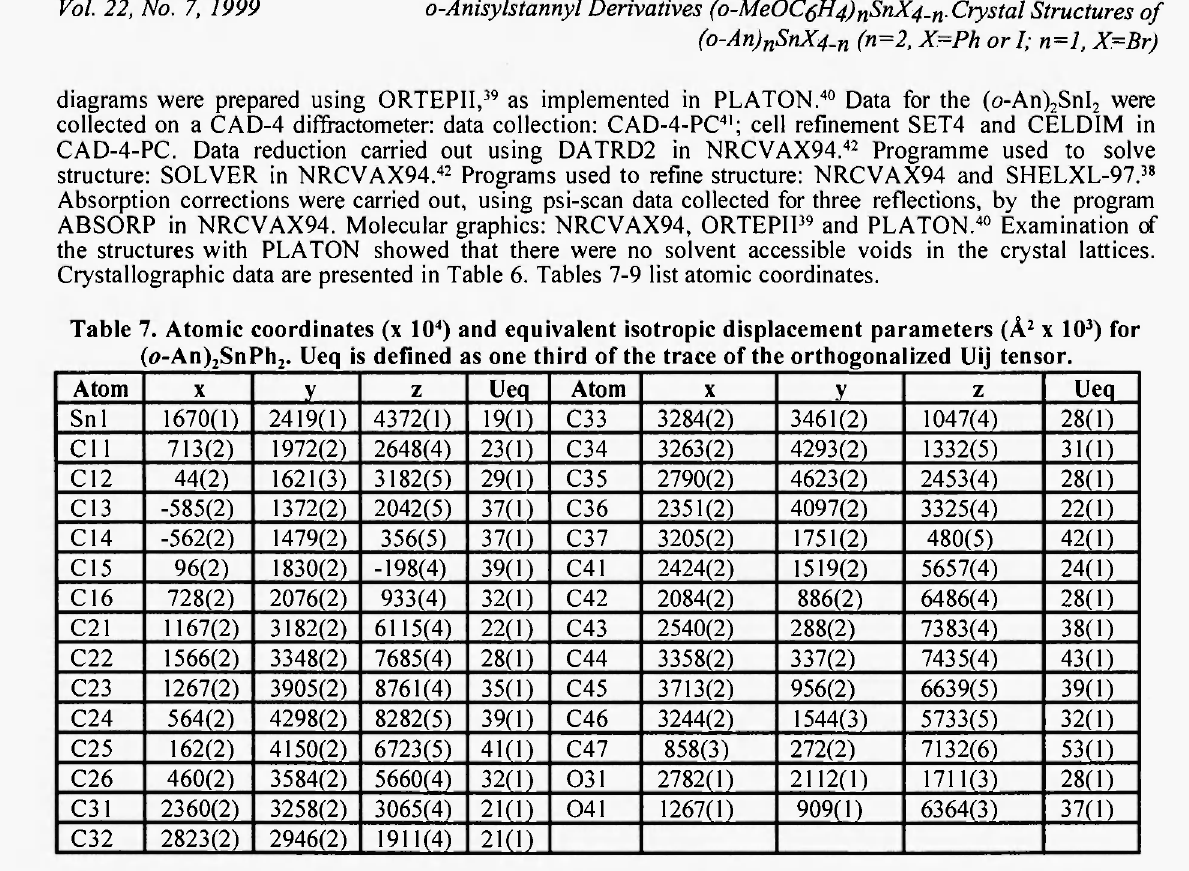
Table 9. Atomic coordinates (χ 10 4 ) and equivalent isotropic displacement parameters (Ä 2 χ 10 3 ) for o-AnSnBr 3 . Ueq is defined as one third of the trace of the orthogonalized Uij